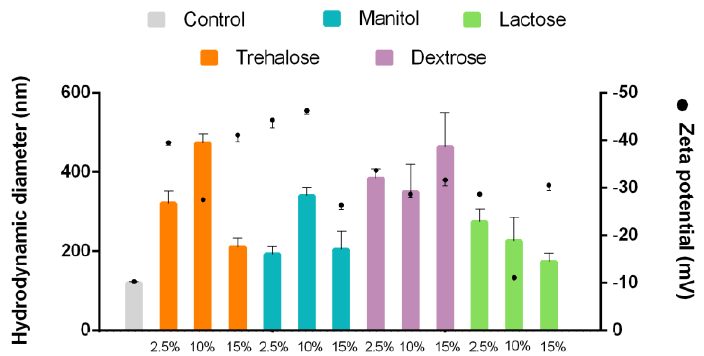
Figure 3. Hydrodynamic diameter and zeta potential of control and reconstitution of NLC with different concentrations of cryoprotectants. n = 3 ± SD.